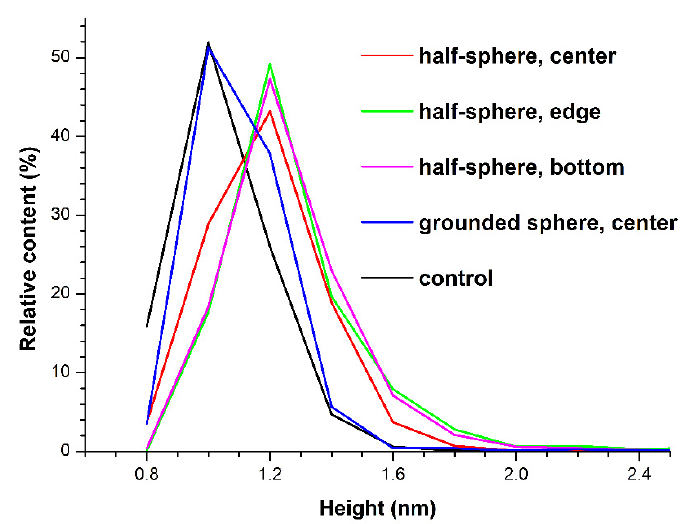
Figure 3. Results of AFM data processing. The plots of the density of the relative distribution of the imaged objects with height ρ (h) (density function plots) obtained for the HRP solutions, which were incubated either 2 m away from the metallic half-sphere (black; control solution); within the half-sphere: in its center (red), near its edge (green), and at its bottom (magenta); or within the grounded metallic sphere (blue). Relative content indicates the number of protein molecules measured at a given height divided by the total number of the molecules visualized on the substrate.